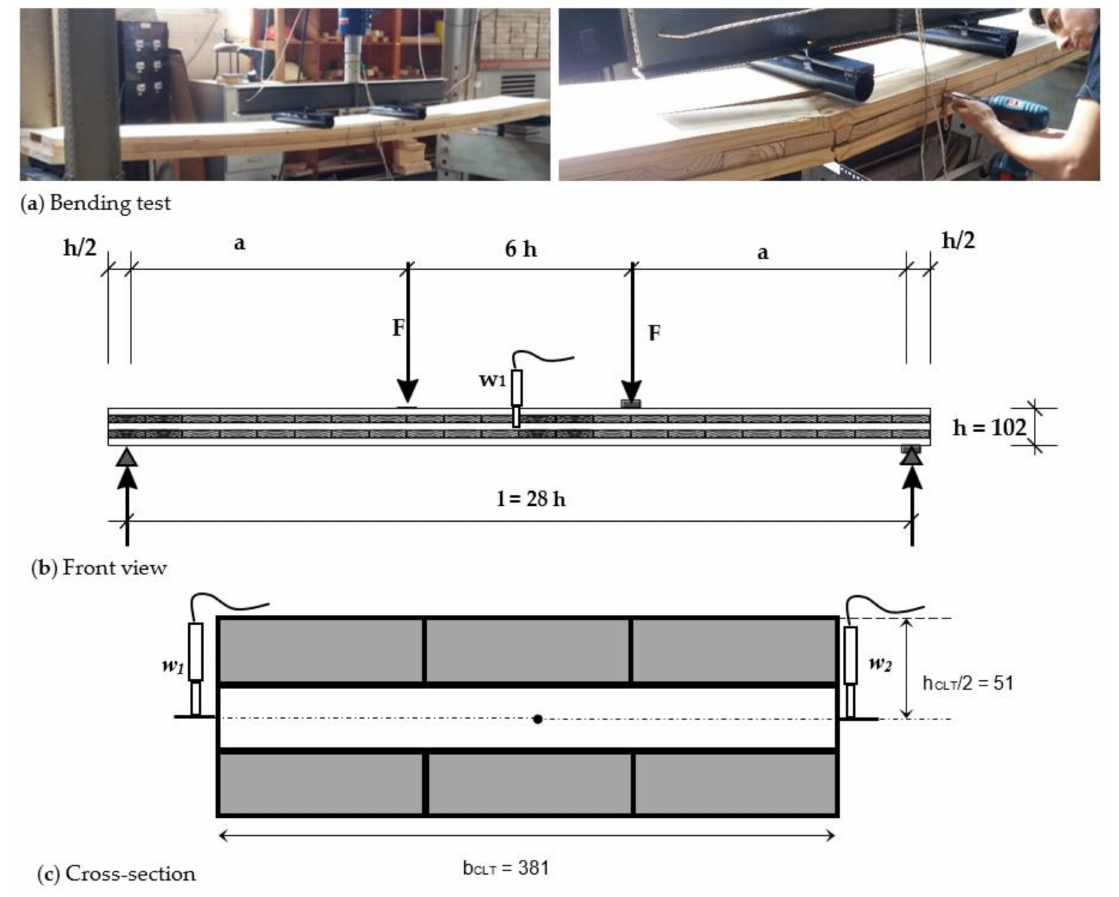
Figure 3. Configuration of the CLT bending test and the location of the linear variable differential transformers (LVDTs): ( a ) bending tests, ( b ) front view, and ( c ) cross-section (dimensions in